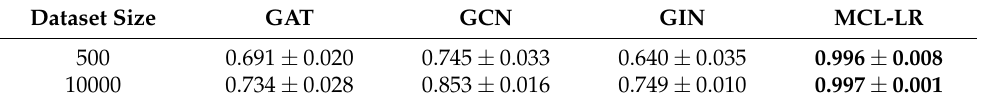
Figure 4. The motif vocabulary constructed in the synthetic data experiments. The learned motifs resemble the templates used to generate the synthetic noisy graphs. Table 1. Graph classification results using synthetic data. The best scores are marked as